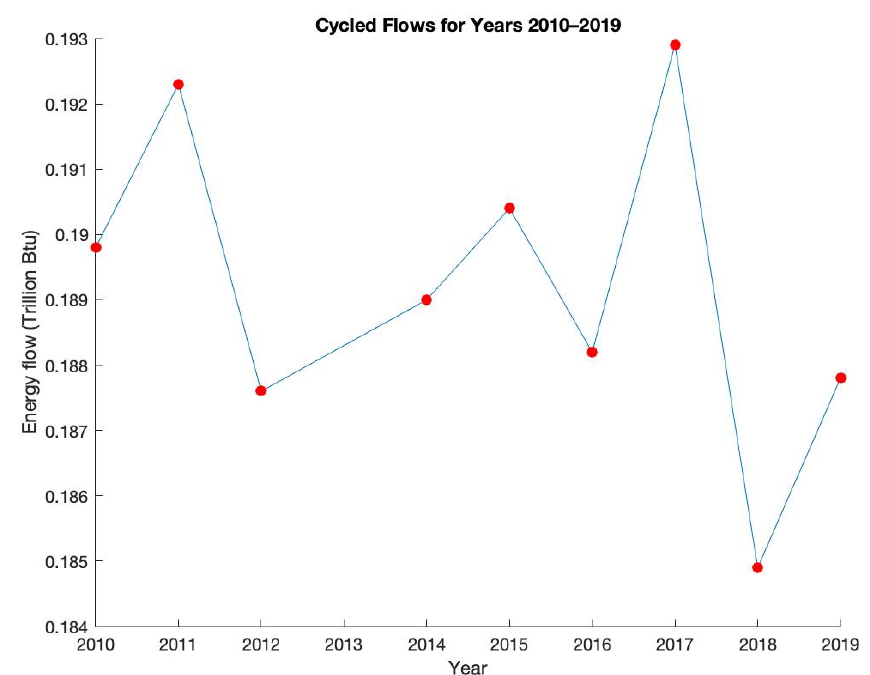
Figure 5. Cycled flows for Maryland’s energy industry from 2010–2019.